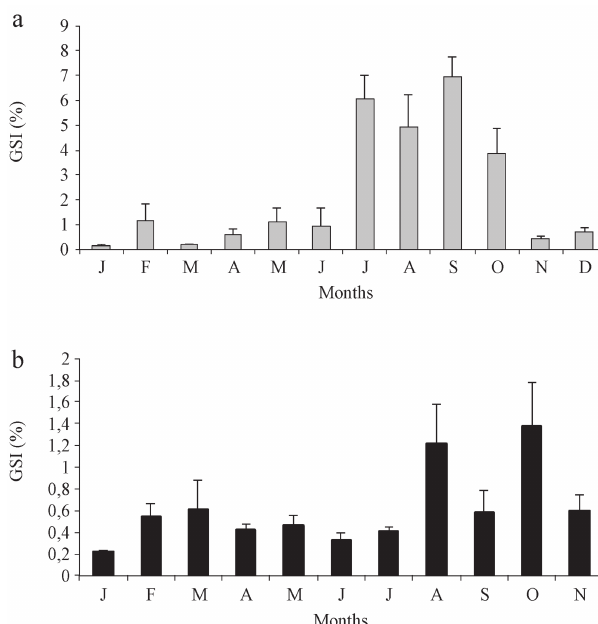
Fig. 6. Seasonal variation of the gonadosomatic index (GSI) for Poecilia sphenops females (a) and males (b).